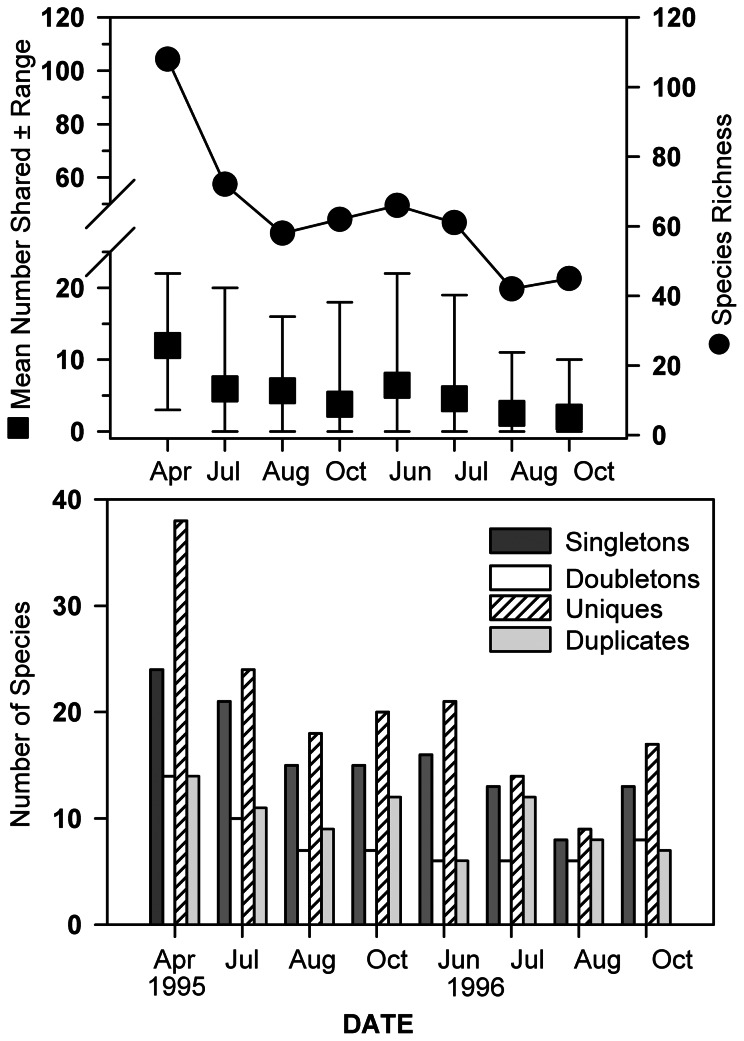
Temporal fluctuations in the mean number of shared taxa (upper) and the number of taxa in several different categories of rarity (lower) in Long Island Sound.Rarity categories are defined in text. The upper graph also shows the fluctuation in the total number of taxa found at each sampling time.